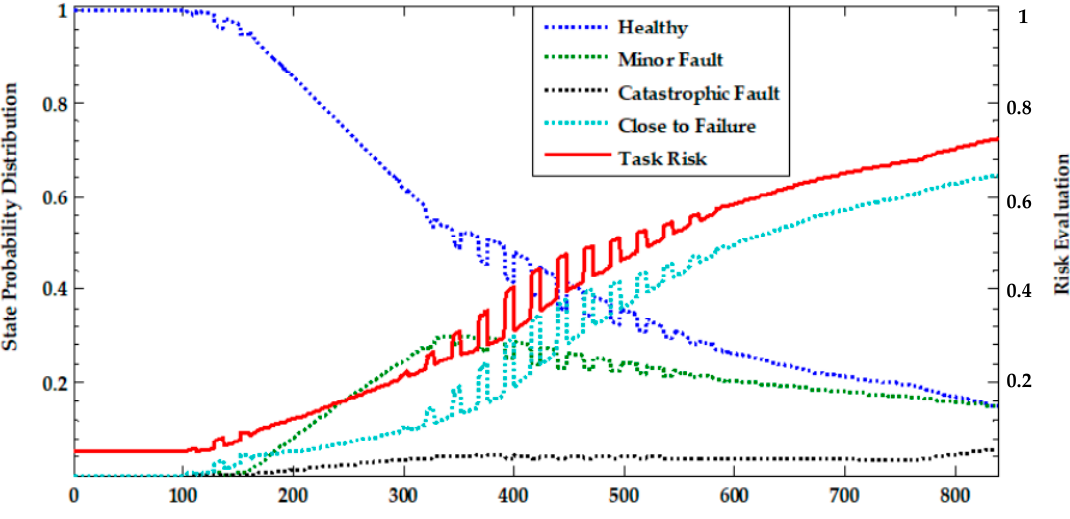
Figure 16. Probability distribution and risk prediction of each state of unmanned system.